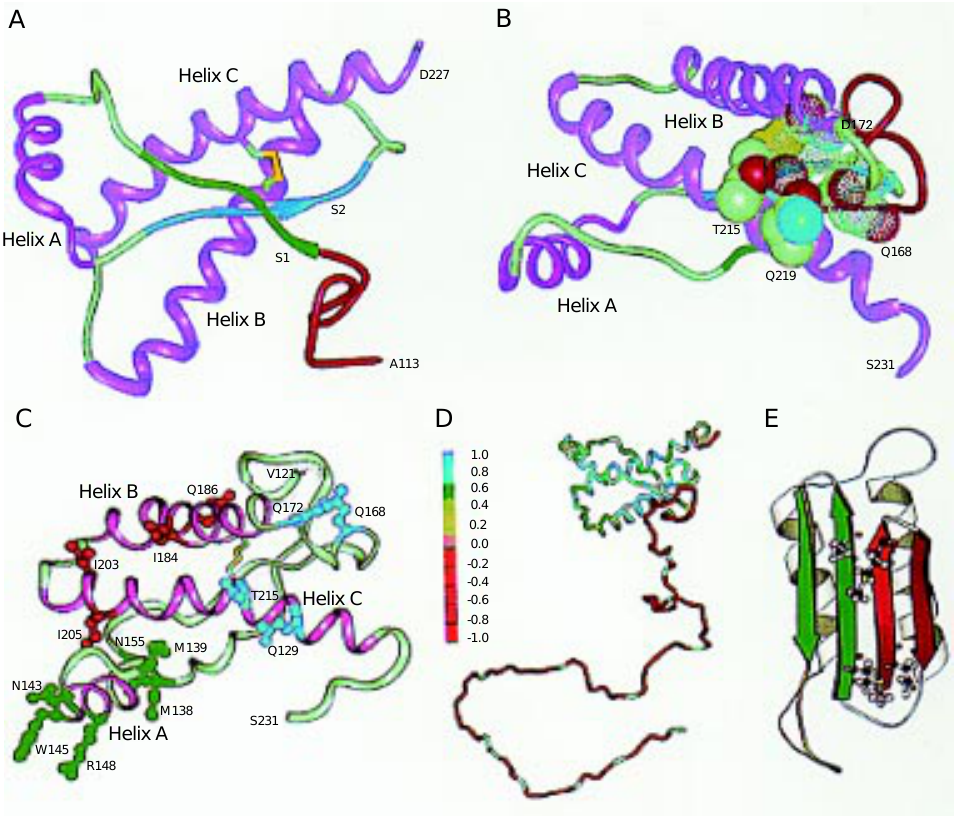
7 - Structure of prion pro- teins. A , NMR structure of ham- ster recombinant PrP (90-231); helices are colored in pink, the disulfide bond in yellow and con- served hydrophobic regions in red. B , NMR structure of recom- binant PrP (90-231) indicating a van der Waals rendering of the residues thought to bind PrP c with a protein X. C , PrP residues governing the transmission of prions across species are indi- cated. D , Schematic diagram of PrP (29-231) showing the flex- ibility of the N-terminal region. E , Plausible model for the ter- tiary structure of PrP sc (repro- duced from Ref. 56 with permis- sion of the author and the owner National Academy of Sciences,